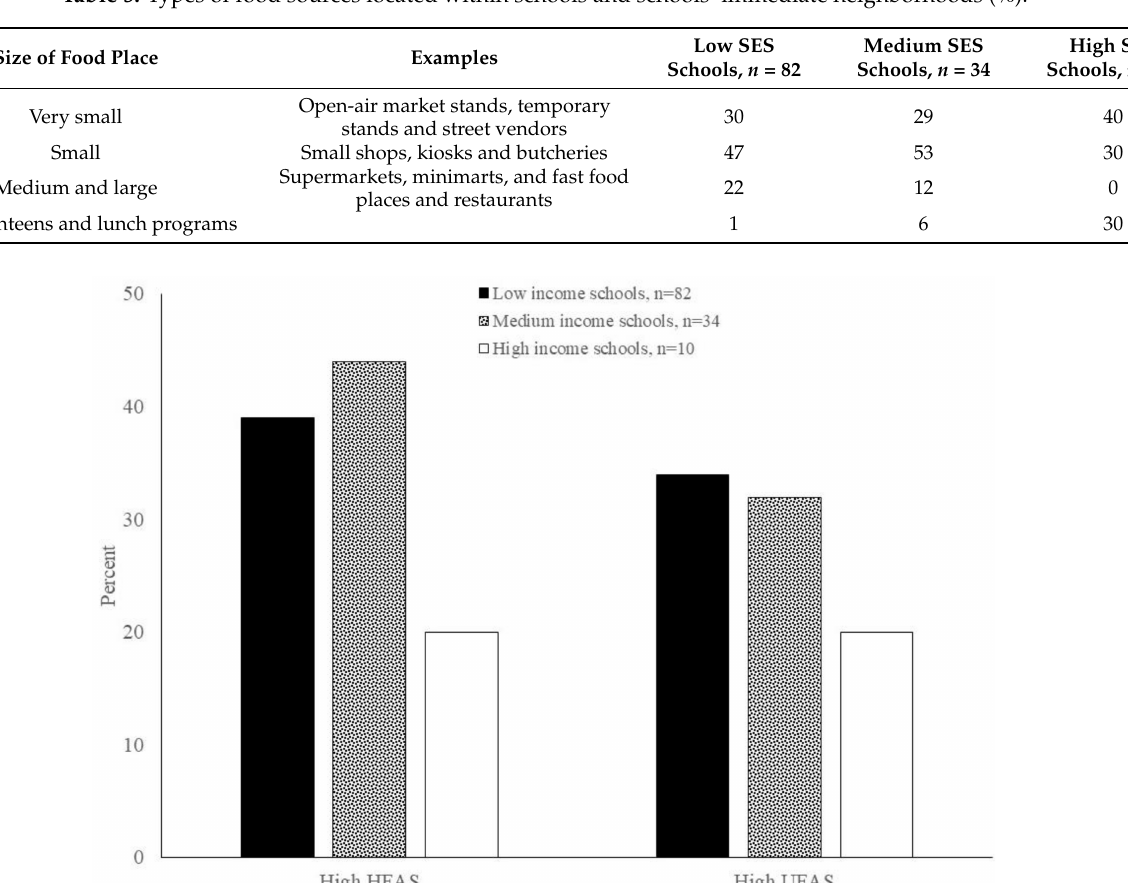
Table 5. Types of food sources located within schools and schools’ immediate neighborhoods (%).